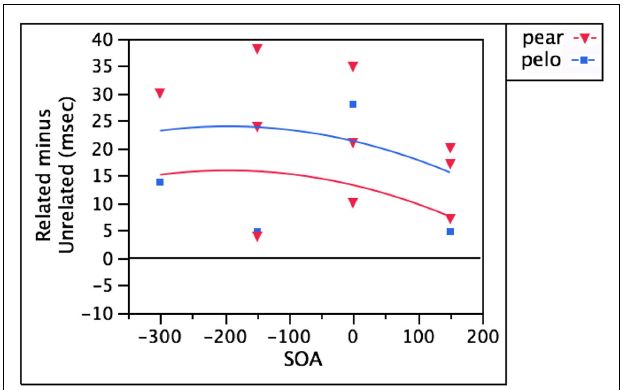
FIGURE 5 | Mixed results for distractors in the non-target language whose translations are phonologically related to the target (muñeca, translates to doll ).